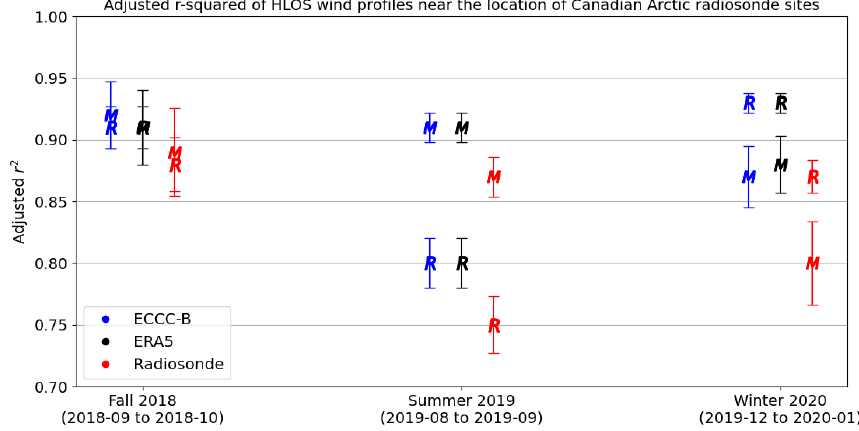
Figure 6. Adjusted r -squared of vertical HLOS wind profiles with a 99% confidence level from coincident Aeolus (Rayleigh, R, and Mie, M) overpasses near radiosonde stations over the Canadian Arctic (shown in Fig. 1) and ECCC-B, ERA5, and radiosonde measurements during autumn 2018 (early FM-A), summer 2019 (early FM-B), and winter 2020